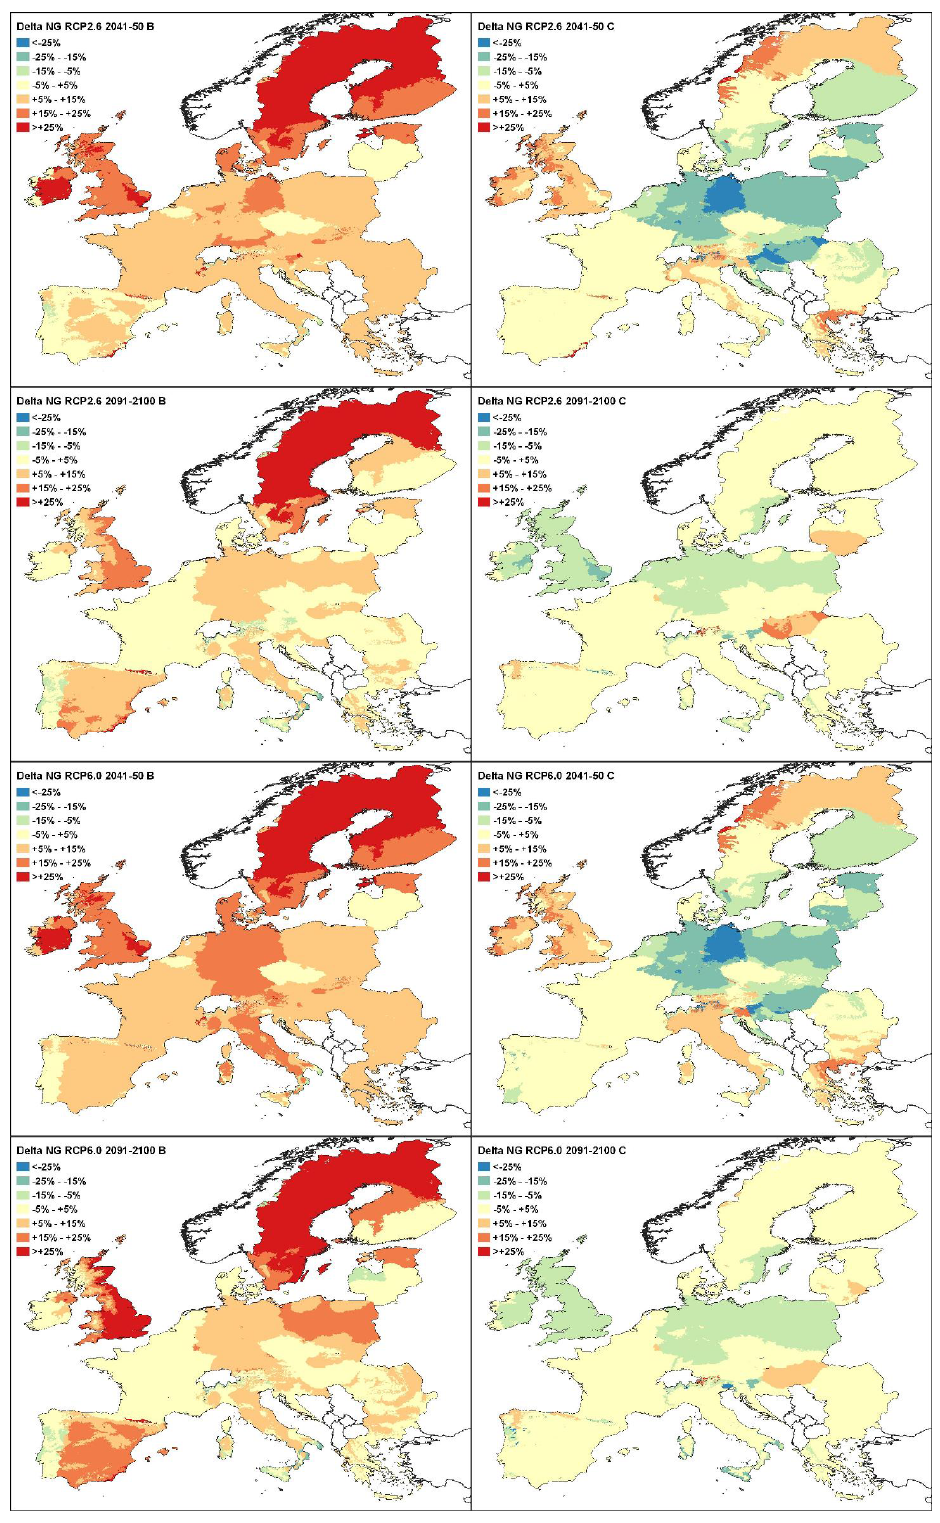
Figure 5. Relative variation in NG due to climate change for broadleaved species (B, on the left side) and conifers (C, on the right side). The relative variation is estimated, for each country and CLU, as the average percentage difference between the NG of the RS and the average NG estimated from the four climatic models within the periods 2041–2050 and 2091–2100. The upper four panels refer to RCP2.6, and the lower four panels refer to